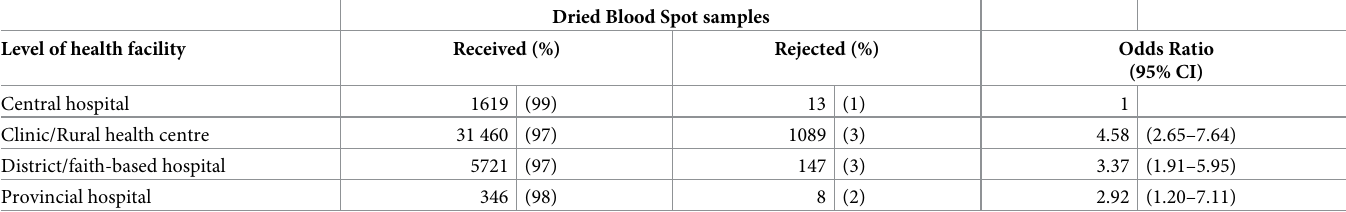
Table 2. The relationship between DBS samples rejected by the NMRL and the level of health facility from which they were collected between January and Decem- ber 2017.